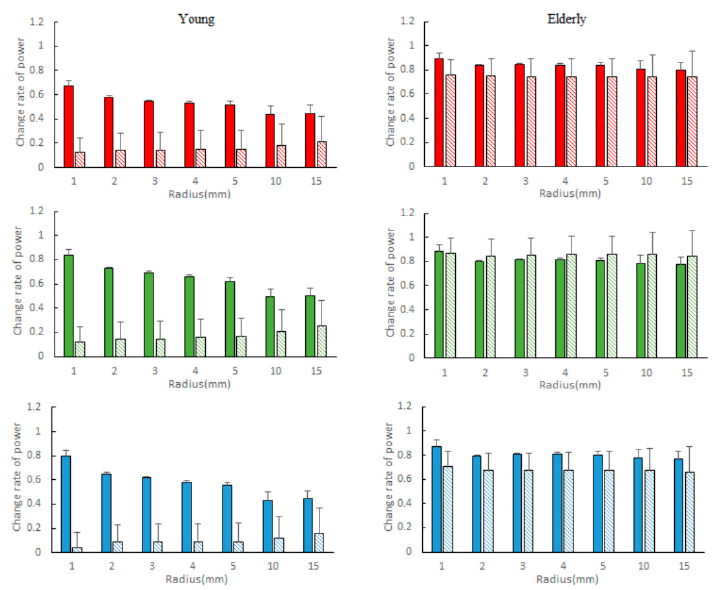
Figure 9. Difference in power at each R value for r = 0. Left: young ( n = 3), right: elderly ( n = 8) solid: low frequency band, fine dotted: high frequency band upper red power, middle green power, lower blue power, mean ±